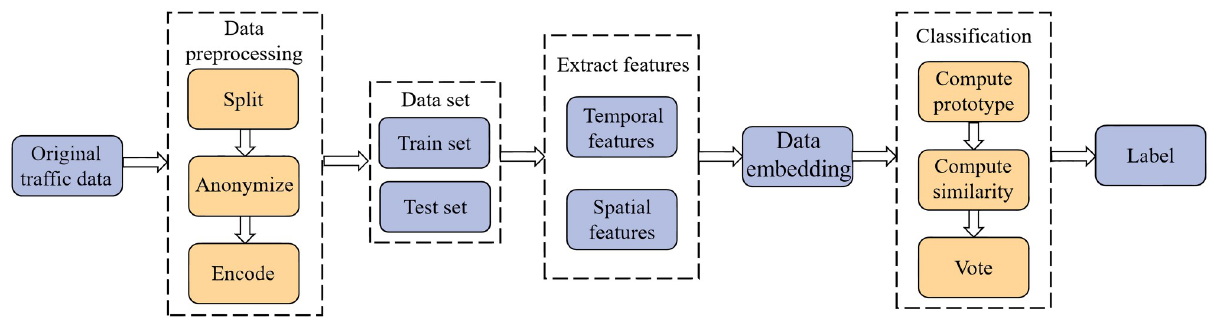
Fig 1. The architecture of the proposed method.